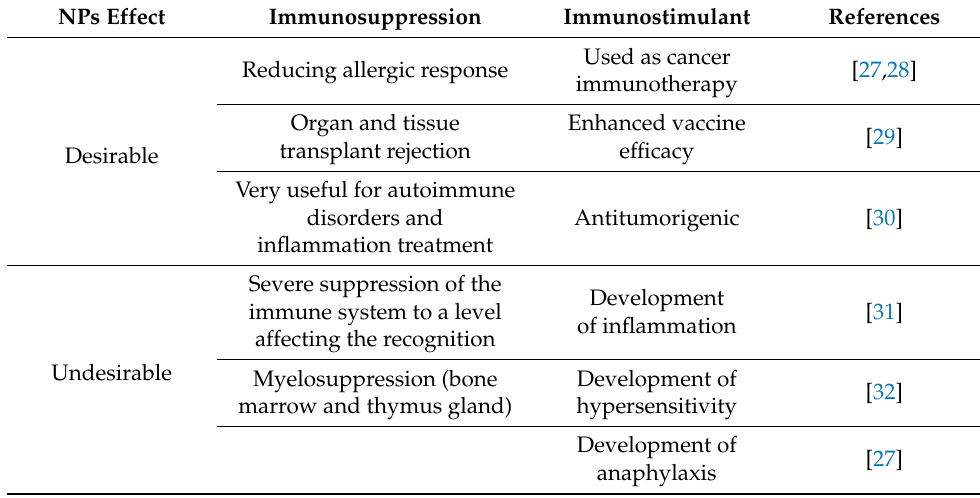
Table 1. Immune system modulation by